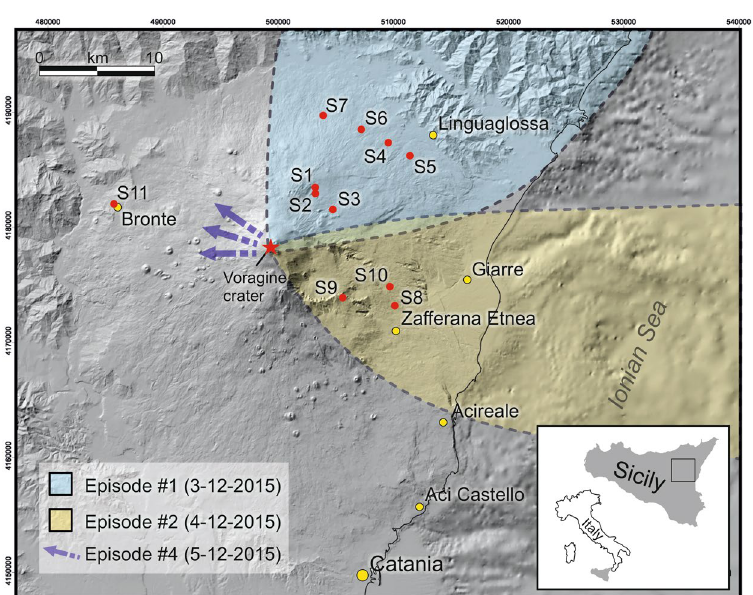
Figure 1. Map of Mt. Etna with sampling sites and dispersal areas of fallout deposits produced by explosive episodes occurring on 3–5 December 2015. Base map reprinted and modified from Journal of Volcanology and